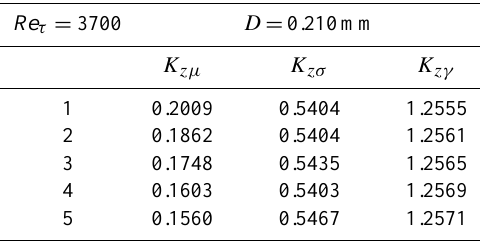
Table 6. List of the parameters K zµ , K zσ , and K zγ , calculated from the sediment diffusivity profiles of the cases listed in Table